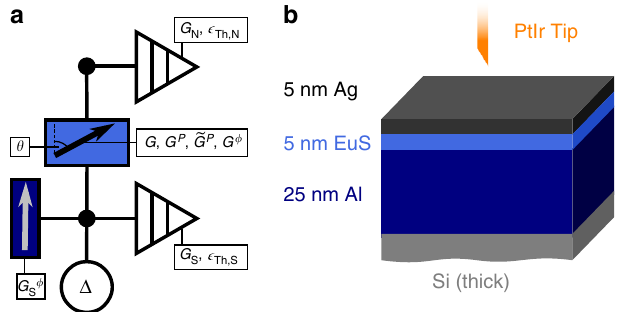
Fig. 1 Illustration of the theoretical and experimental setup. a Circuit diagram representing the theoretical model. A superconducting S-node with a Δ -pseudo-terminal is connected to a normal conducting N-node (both with conductances G S/N and Thouless energies ϵ ) via a tunnelling N = S connector. The connector has the spin-dependent parameters ~ G P ; G P and G ϕ , which depend on the relative magnetisation direction θ to the spin- dependent G ϕ term of the S-node. The relative angle θ between those magnetisations is the main free parameter in our fi ts. b Schematic of the tunnel contact. A PtIr tip (normal metal) is brought into tunnel contact with a trilayer sample of an EuS layer sandwiched between a normal conducting Ag and a superconducting Al fi